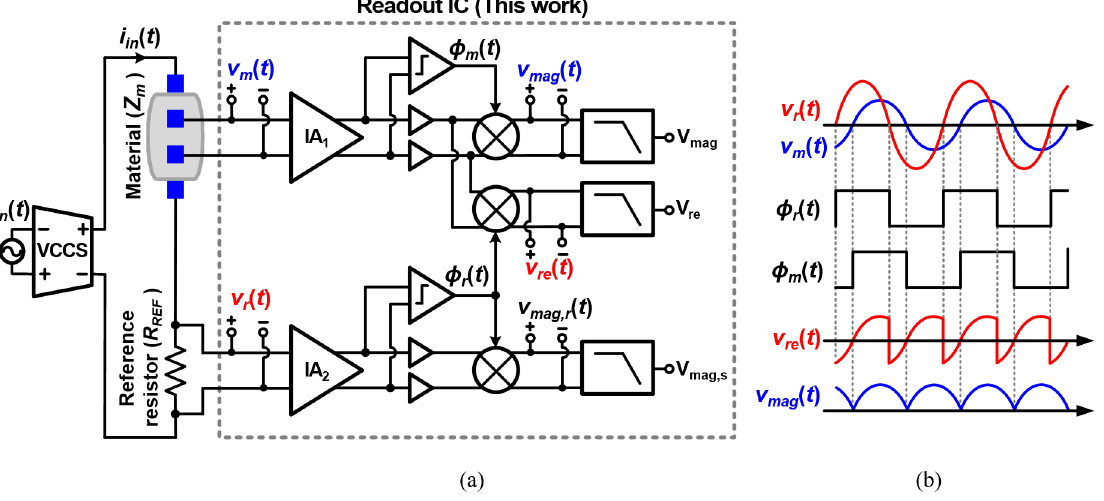
Figure 5. ( a ) Simplified block diagram of the proposed impedance measurement IC and ( b ) its operation